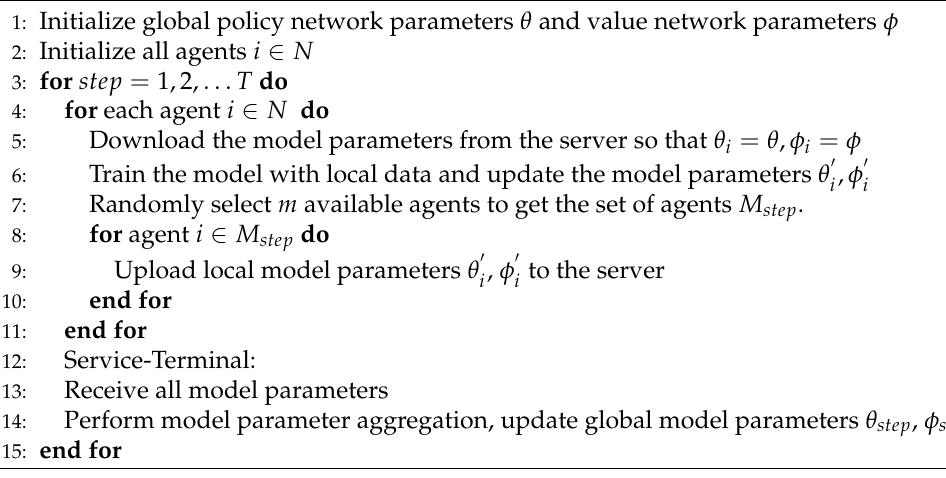
Algorithm 1 weight prediction model training algorithm based on federated